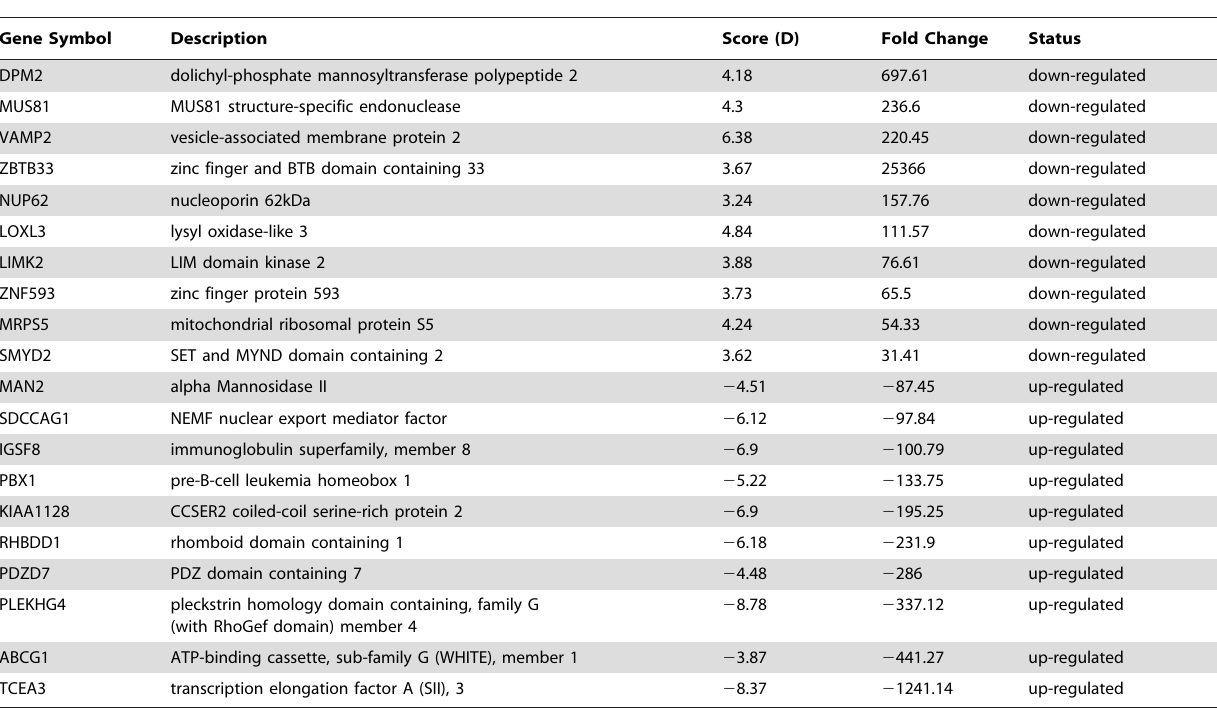
The symbol name, description, D score and the expression fold change were provided. doi:10.1371/journal.pone.0085784.t002 Table 3. Summary of differentially expressed genes between OA vs. NT